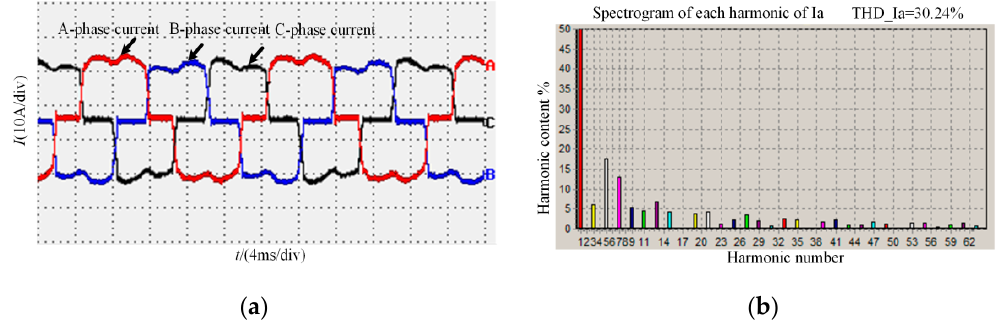
Figure 18. Before compensation: ( a ) Grid current; ( b ) Current THD.